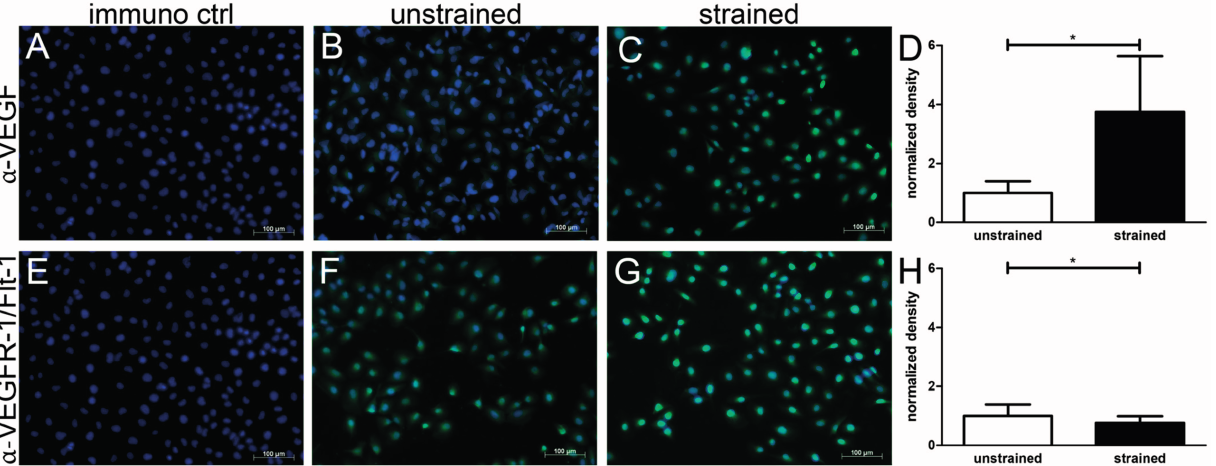
Figure 4. Expression of VEGF and VEGFR-1 in human chondrocytes. Representative immunofluorescent staining of VEGF and VEGFR-1 in C-28/I2 chondrocytes. Cells were strained for 12 h with cyclic square waveforms at 0.5 Hz and 8% relative stretching. Green Alexa Fluor ® 488-specific signals for VEGF ( top row ) and VEGFR-1 ( bottom row ) are shown, while nuclei appear in blue (bisbenzimid). Staining control without primary antibody (immuno ctrl: A , E ); unstrained cells ( B , F ), strained ( i.e. , stretched) cells ( C , G ). Scale bars represent 100 μ m. Signal intensity of the anti VEGF staining ( D ) and VEGFR-1/Flt-1 ( H ) was quantified by ImageJ. Signal intensity of unstrained cells was set to 1. * indicates p ≤ 0.05, n = 3.